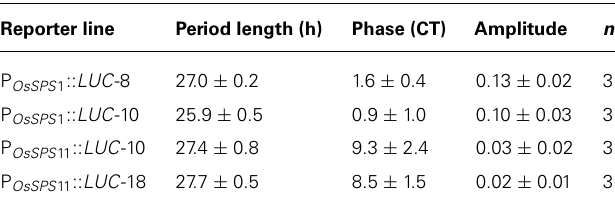
Table 2 | Bioluminescence rhythms of P OsSPS1 :: LUC and P OsSPS11 :: LUC reporter plants at 30 ◦ C under continuous light conditions. Reporter line